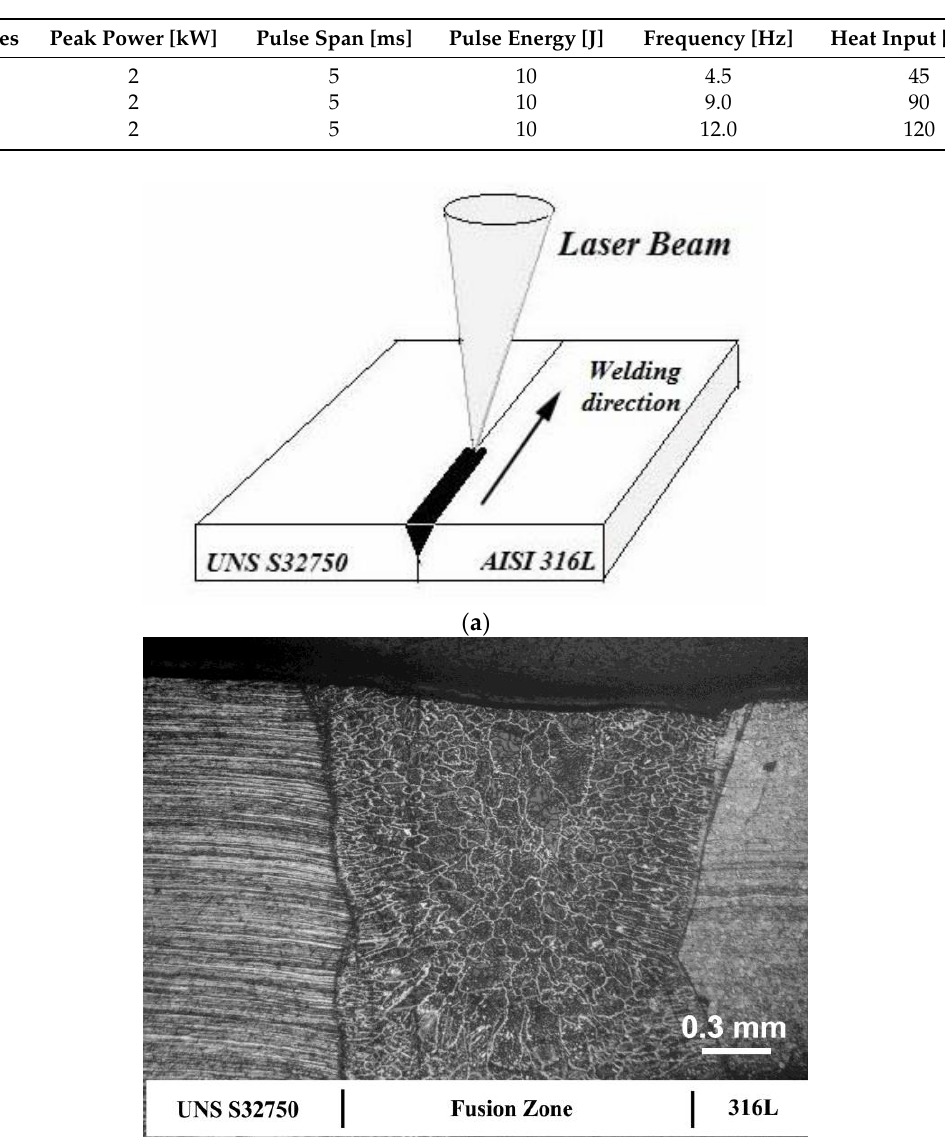
Figure 1. ( a ) Schematic of the dissimilar steels butt joint; ( b ) optical macrograph of the welded